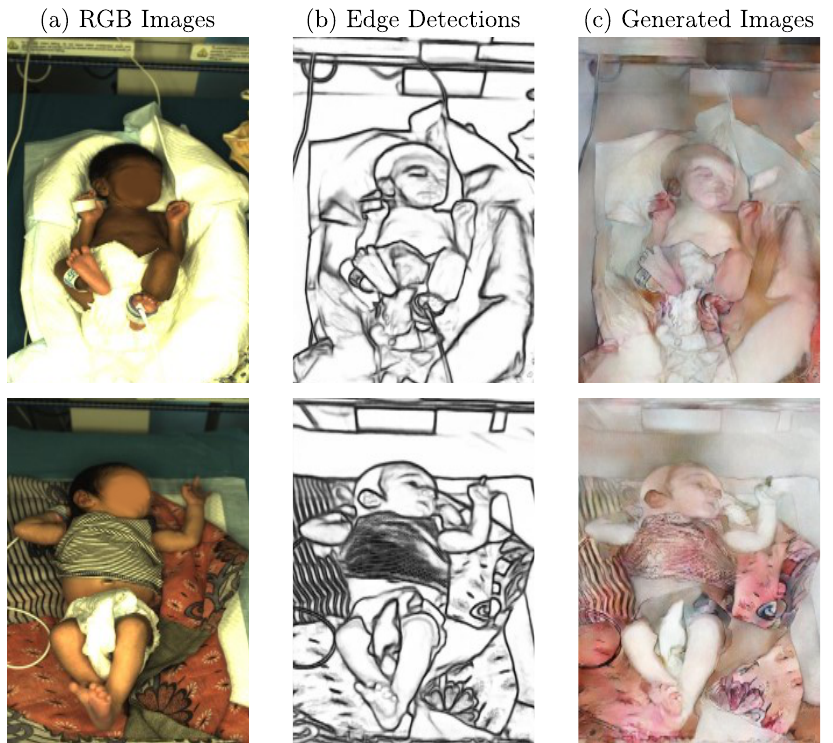
Figure 12. ( a ) Example RGB frames with ( b ) corresponding edge detections and ( c ) failed gener- ated